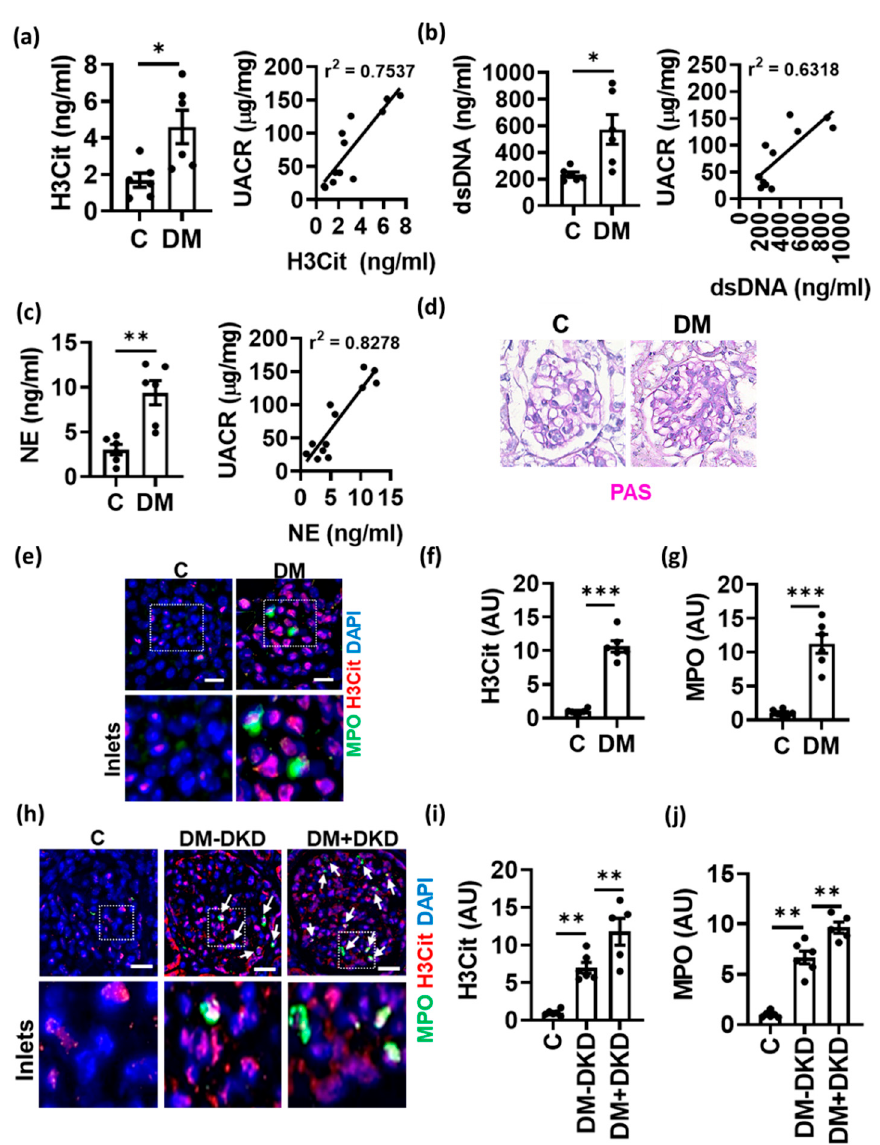
Figure 1. Increased NETs in diabetic kidney disease. ( a – c ) Plasma levels of H3Cit, dsDNA and neutrophil elastase, NE (bar graphs with dot-plot) in non-diabetic control (C) and diabetic (DM, STZ-model) mice. ( d ) Representative images showing PAS staining in diabetic (DM) versus non- diabetic control (C) mice. ( e – j ) Immunofluorescence staining (( e , h ): representative images; ( f , g , i , j ): bar graphs with dotplot summarizing results) of glomeruli showing H3Cit staining (red) and MPO staining (green) in control (C) and diabetic mice (DM, ( e – g )) and human kidneys from non-diabetic controls (C) and diabetic patients without (DM-DKD) or with (DM+DKD) diabetic kidney disease ( h – j ). Correlation (Pearson’s correlation) of H3Cit, dsDNA and NE with urinary albumin creatinine ratio (UACR, line graphs, a – c ). Each dot represents one mouse (( a – c , f , g ), n = 6 mice each group) or one human sample ( i , j ); ( e , h ): scale bar, 50 µ m; ( a – c , f , g , i , j ): * p < 0.05, ** p < 0.01, *** p < 0.001, t